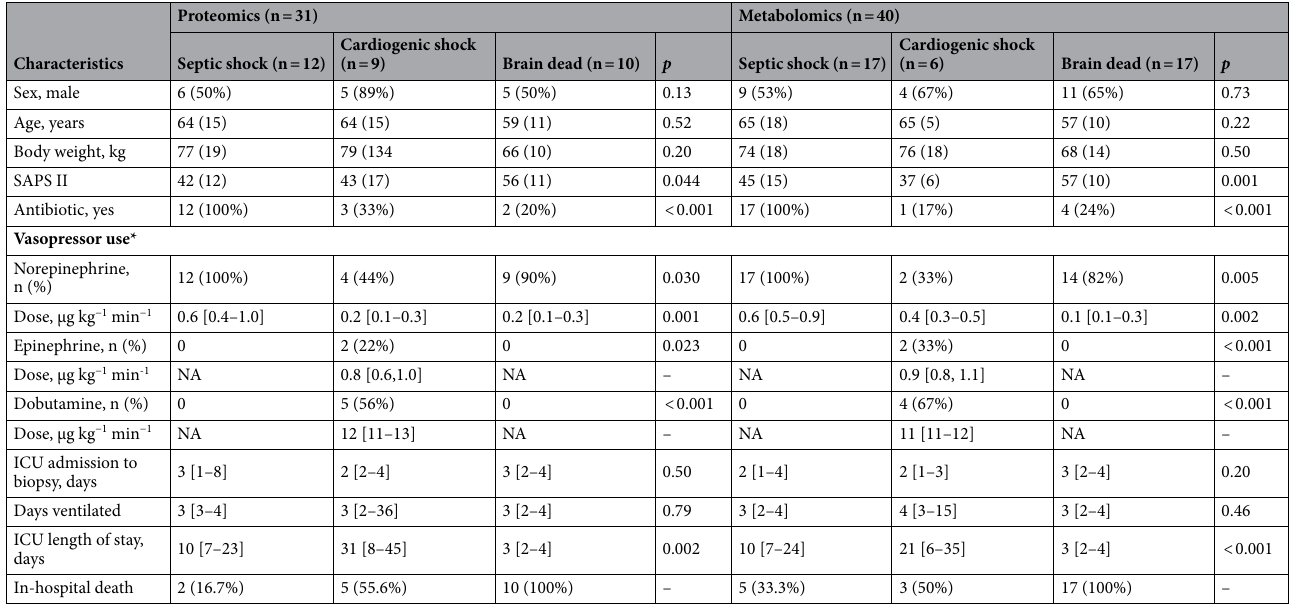
Table 1. Basal characteristics of the three patient groups. The results are presented in count (%), mean (standard deviation) or median [interquartile range]. The doses of vasopressors are the highest recorded on the day of the muscle biopsy. * The patients in the C group may have receive vasopressors combinations. SAPS II, Simplified acute physiology score II. ICU, Intensive care unit. NA, Non